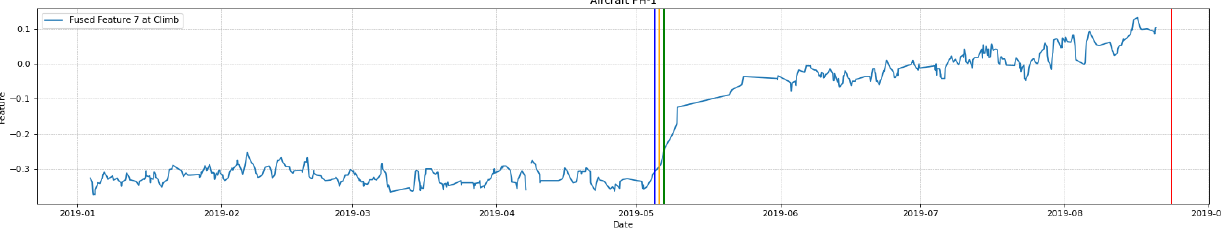
Figure 8. Fused feature 1 at Climb of aircraft